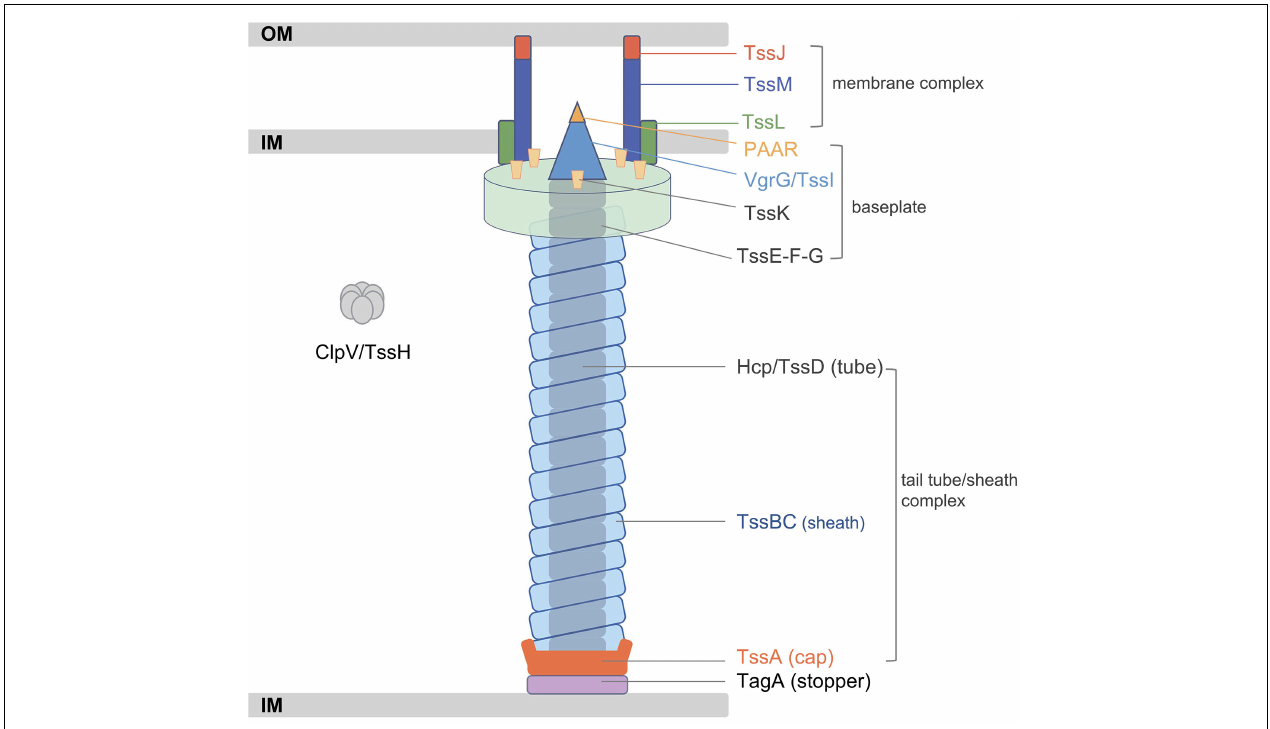
FIGURE 1 | Schematic representation of the classic type VI secretion system (T6SS). Adapted from Cherrak et al. (2019). IM, inner membrane; OM, outer membrane.